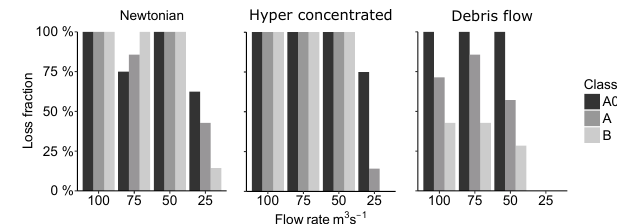
Figure 13. Building loss fraction for all flow scenarios where build- ings are assumed to have a brick width of